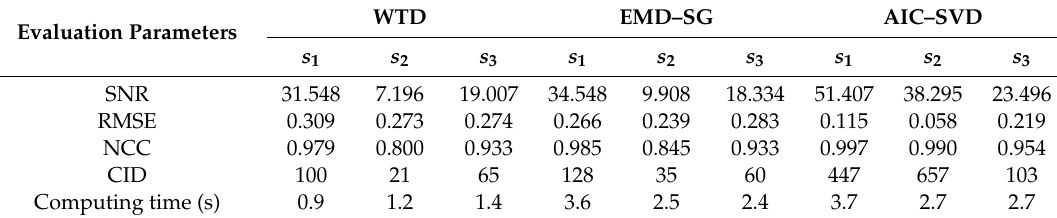
Table 2. Denoising performance parameters at SNR of 5 dB.